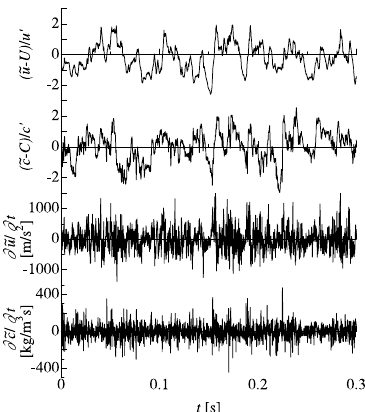
Fig. 5 Typical time signals of the axial velocity, concentration and their temporal derivatives